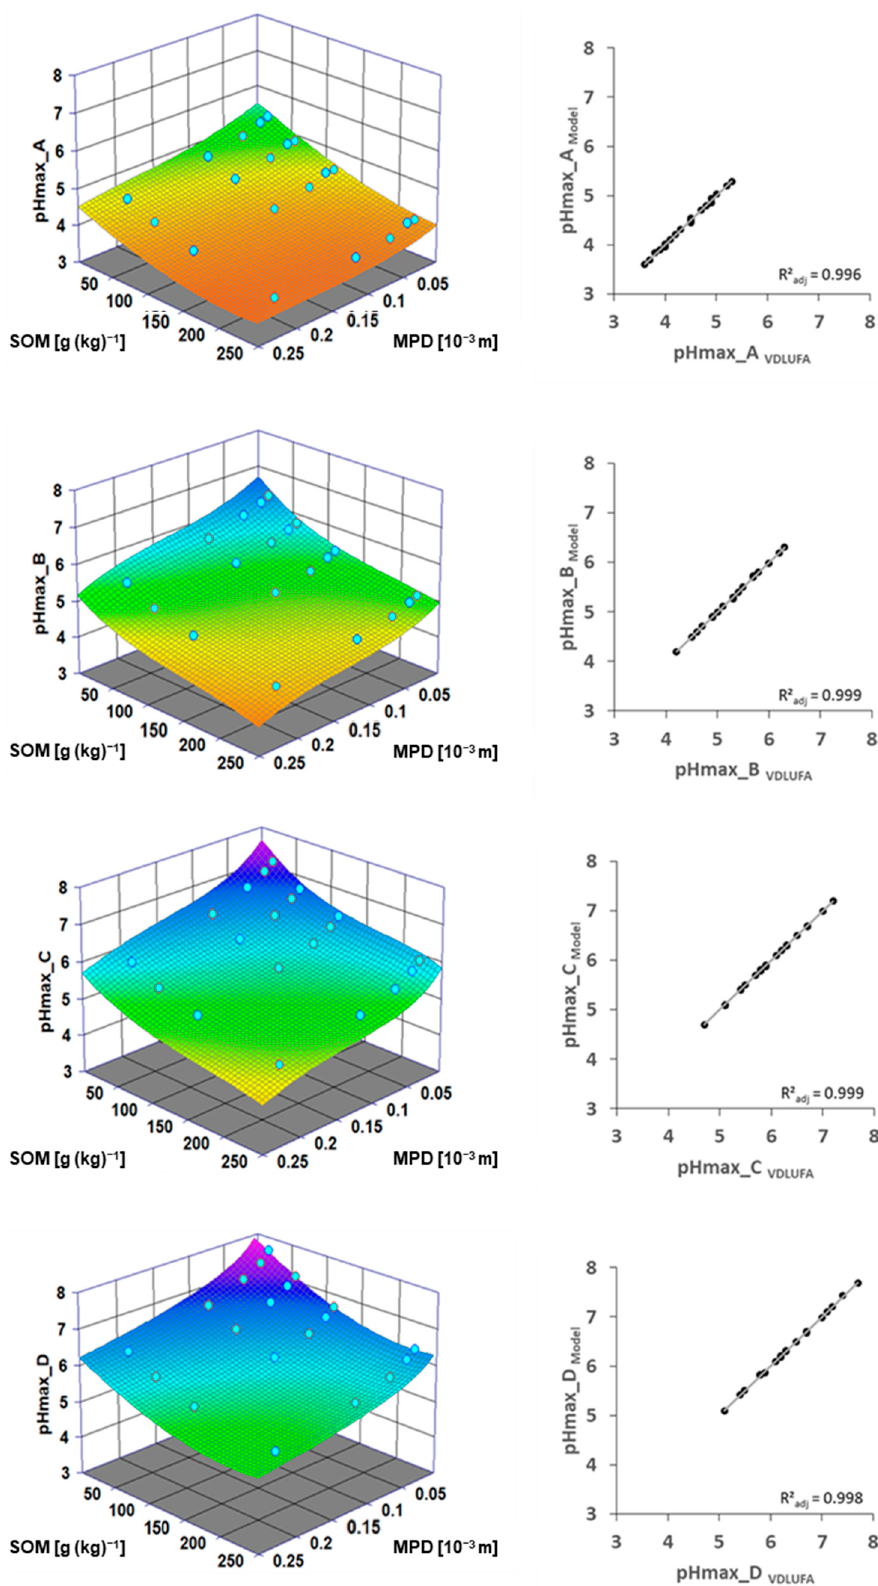
Figure 5. Left: Upper pH limits of the lime supply statuses (pHmax_A–D) as used by the VDLUFA approach (dots) and calculated according to Equations (3)–(6) (surfaces), always in relation to the soil organic matter (SOM) content and the mean particle diameter (MPD). Right: maximum pH values as predicted by Equations (3)–(6) (pHmax_A–D Model ) vs. the observed pH values by the VDLUFA approach (pHmax_A–D VDLUFA ).